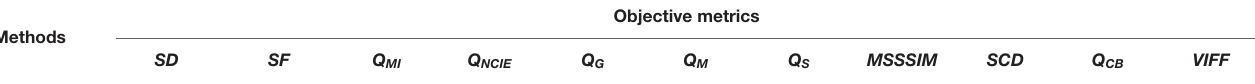
TABLE 4 | The quantitative evaluation of different comparison methods on the MRI-CT dataset. Methods